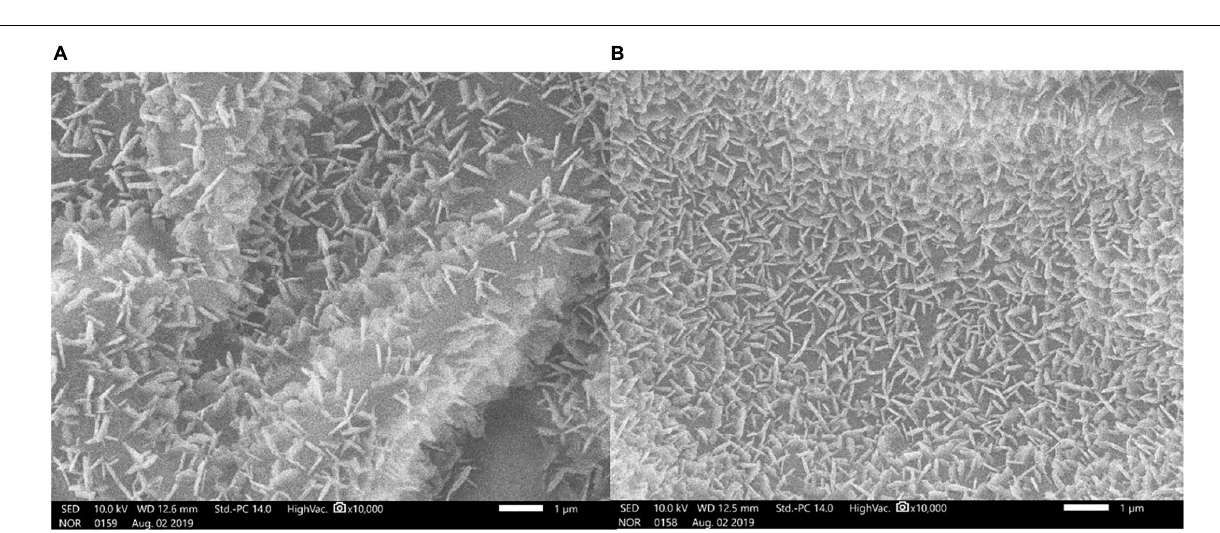
FIGURE 7 | Scanning electron microscopy (SEM) analysis (2,000 × with 20 µ m bar scale) of epicuticular wax depositions on the leaf surfaces of cluster bean cultivar RGC-1025 (A) control leaf and (B) drought-stressed